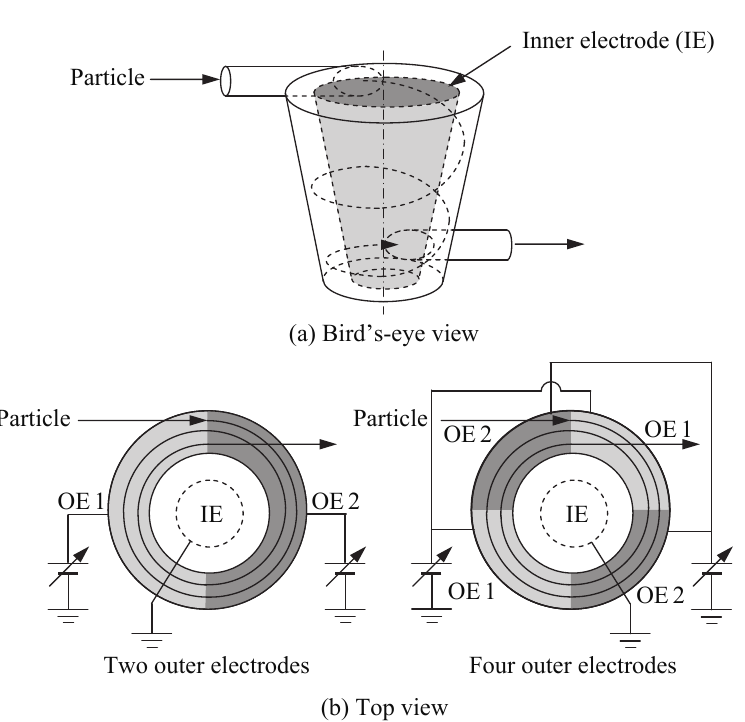
Fig. 7 Conceptual model of particle charge control based on contact potential difference ( V = V see Eq.